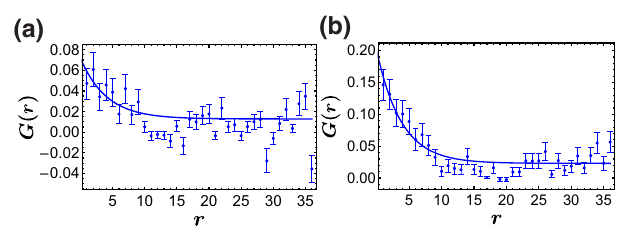
FIG. 7. State preparation and measurement through composite pulses. (a) Measured spin-spin correlation using single pulses for N = 55 and T = 4 ms, from which we fit R = 4.0 ± 1.4. (b) The same experiment using composite pulses, which gives R = 3.8 ± 0.8. The composite pulse method gives smoother results at large